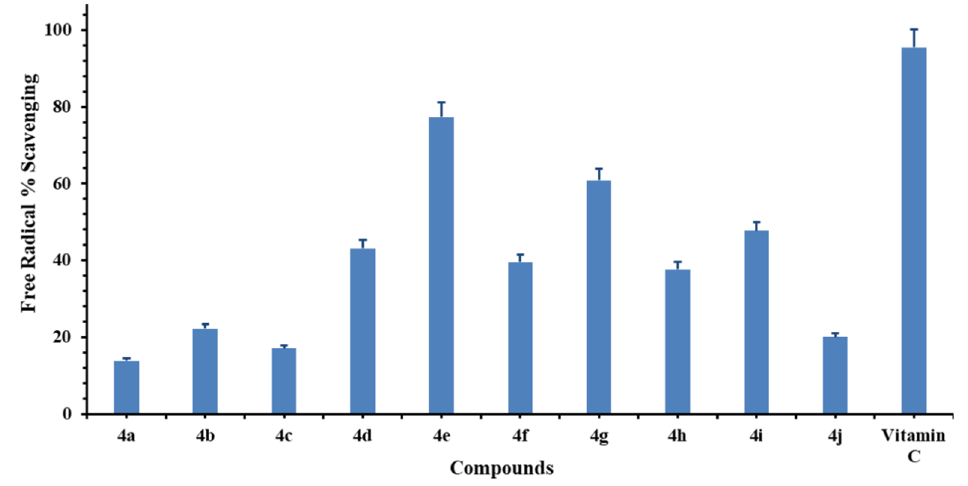
Figure 2. Free radical scavenging activity [%] of the synthesized compounds [ 4a – j ].